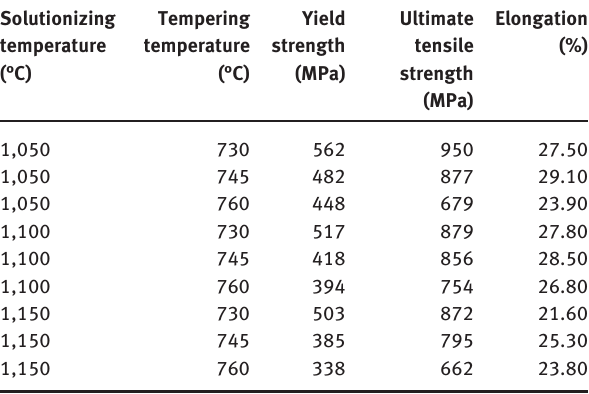
Table 4: Tensile results of heat-treated test samples of T92 steel.